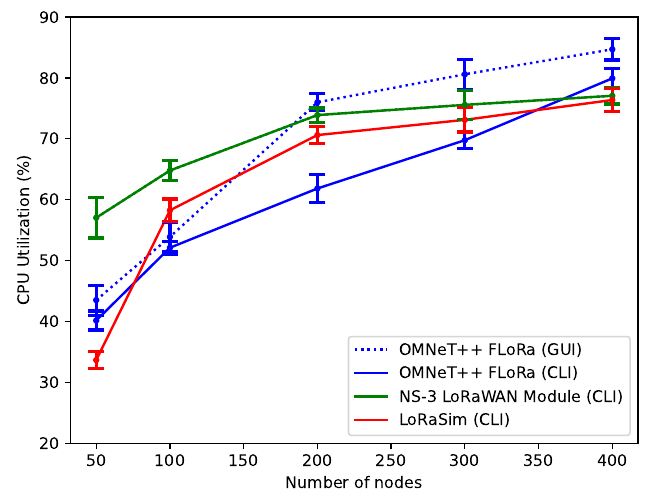
Figure 9. CPU utilization vs. number of